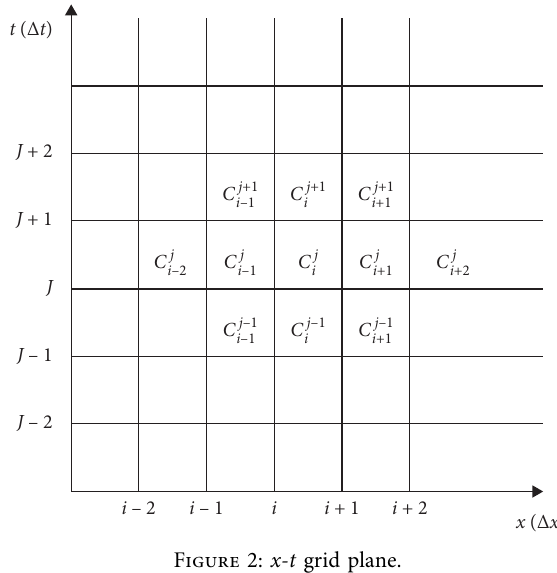
Figure 2: x - t grid